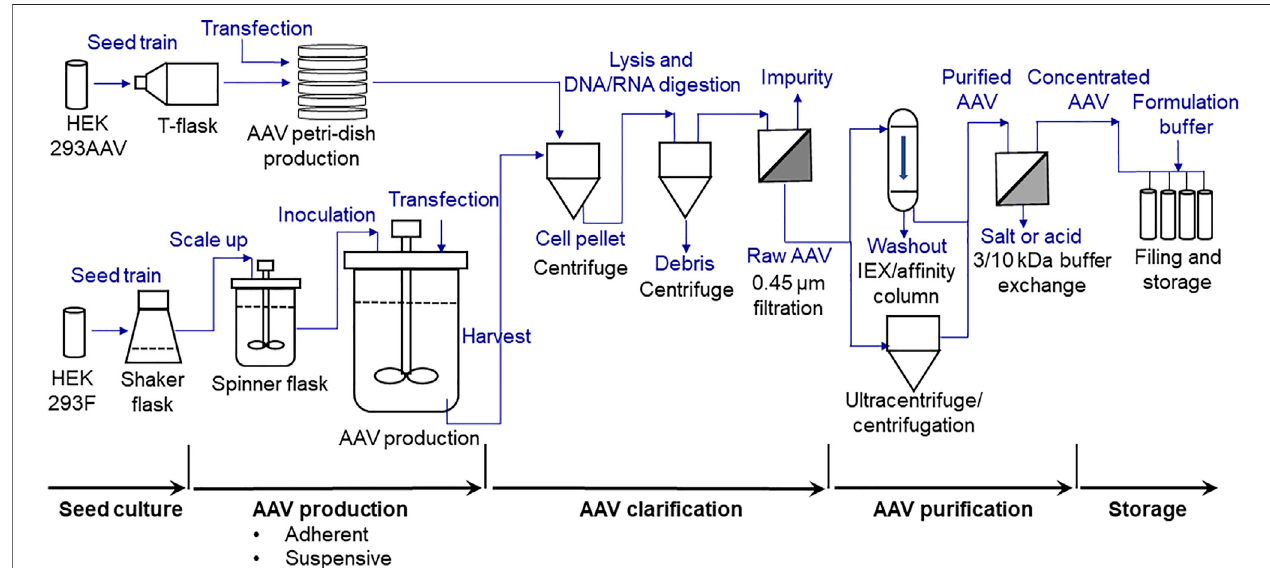
FIGURE 1 | Process fl ow diagram (PFD) of scalable high-yield production of AAV, including seed culture preparation, adherent and suspensive productions, clari fi cation, puri fi cation (ultracentrifugation used in this study) and storage.